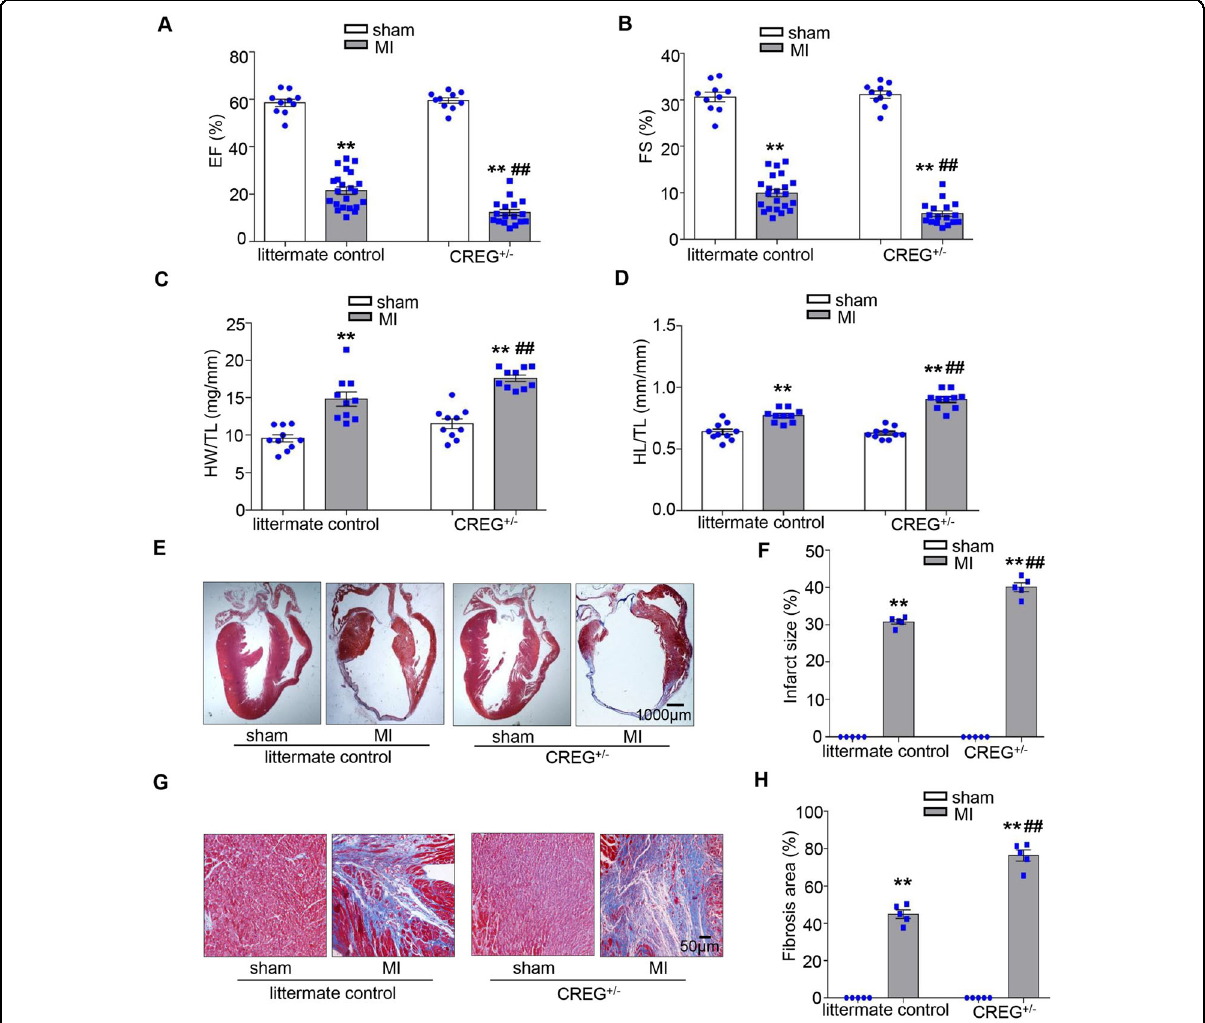
Fig. 2 CREG de fi ciency exacerbated cardiac dysfunction and cardiac fi brosis on day 14 after MI. A , B EF% and FS% in CREG heterozygous mice (CREG + / − ) mice and littermate control mice on post-MI day 14 (sham group, N = 10; MI group of littermate control mice, N = 22; and MI group of CREG + / − mice, N = 17). C , D The heart weight-to-tibial length (HW/TL) ratio and heart length-to-tibial length (HL/TL) ratio in CREG + / − mice and littermate control mice on post-MI day 14 ( N = 10 per group). E , F Masson trichrome staining in CREG + / − mice and littermate control mice on post- MI day 14 ( N = 5 per group). G , H Fibrosis in border zone tissue in CREG + / − mice and littermate control mice on post-MI day 14 ( N = 5 per group). ** P < 0.01 vs. sham group; ## P < 0.01 vs. littermate control-MI